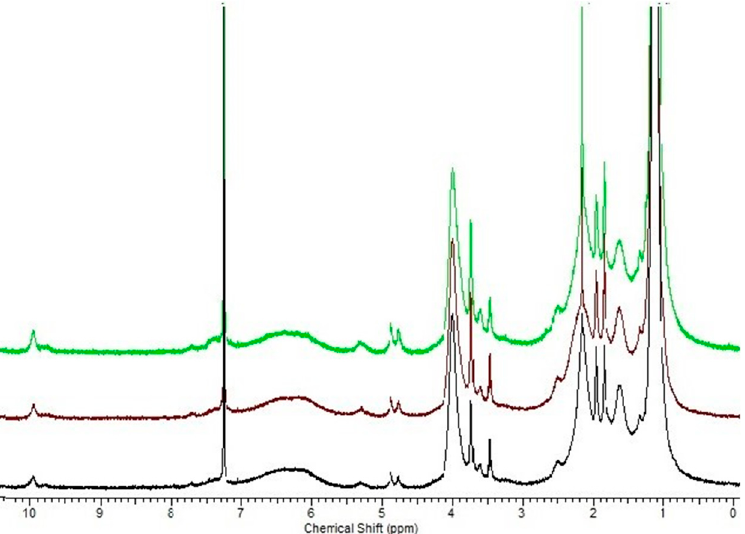
Figure 1. 1 H NMR spectra of DEAMVA (DE)-05-10 (black), DE-05-15 (brown) and DE-05-20 (green). Table 1. Composition of functional photo cross-linkable smart polymers based on vanillin derivatives VA, DEAMVA and DMAMVA (DM).